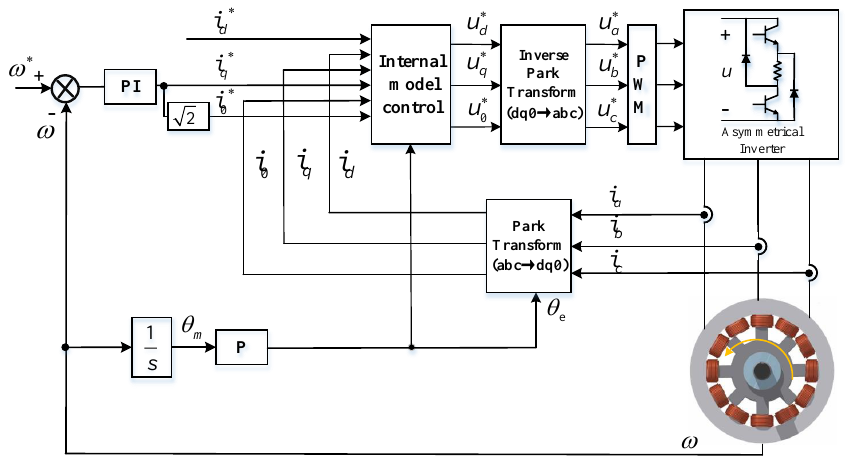
Figure 1. Structure diagram of SRM control system based on the 2DOF IMC.